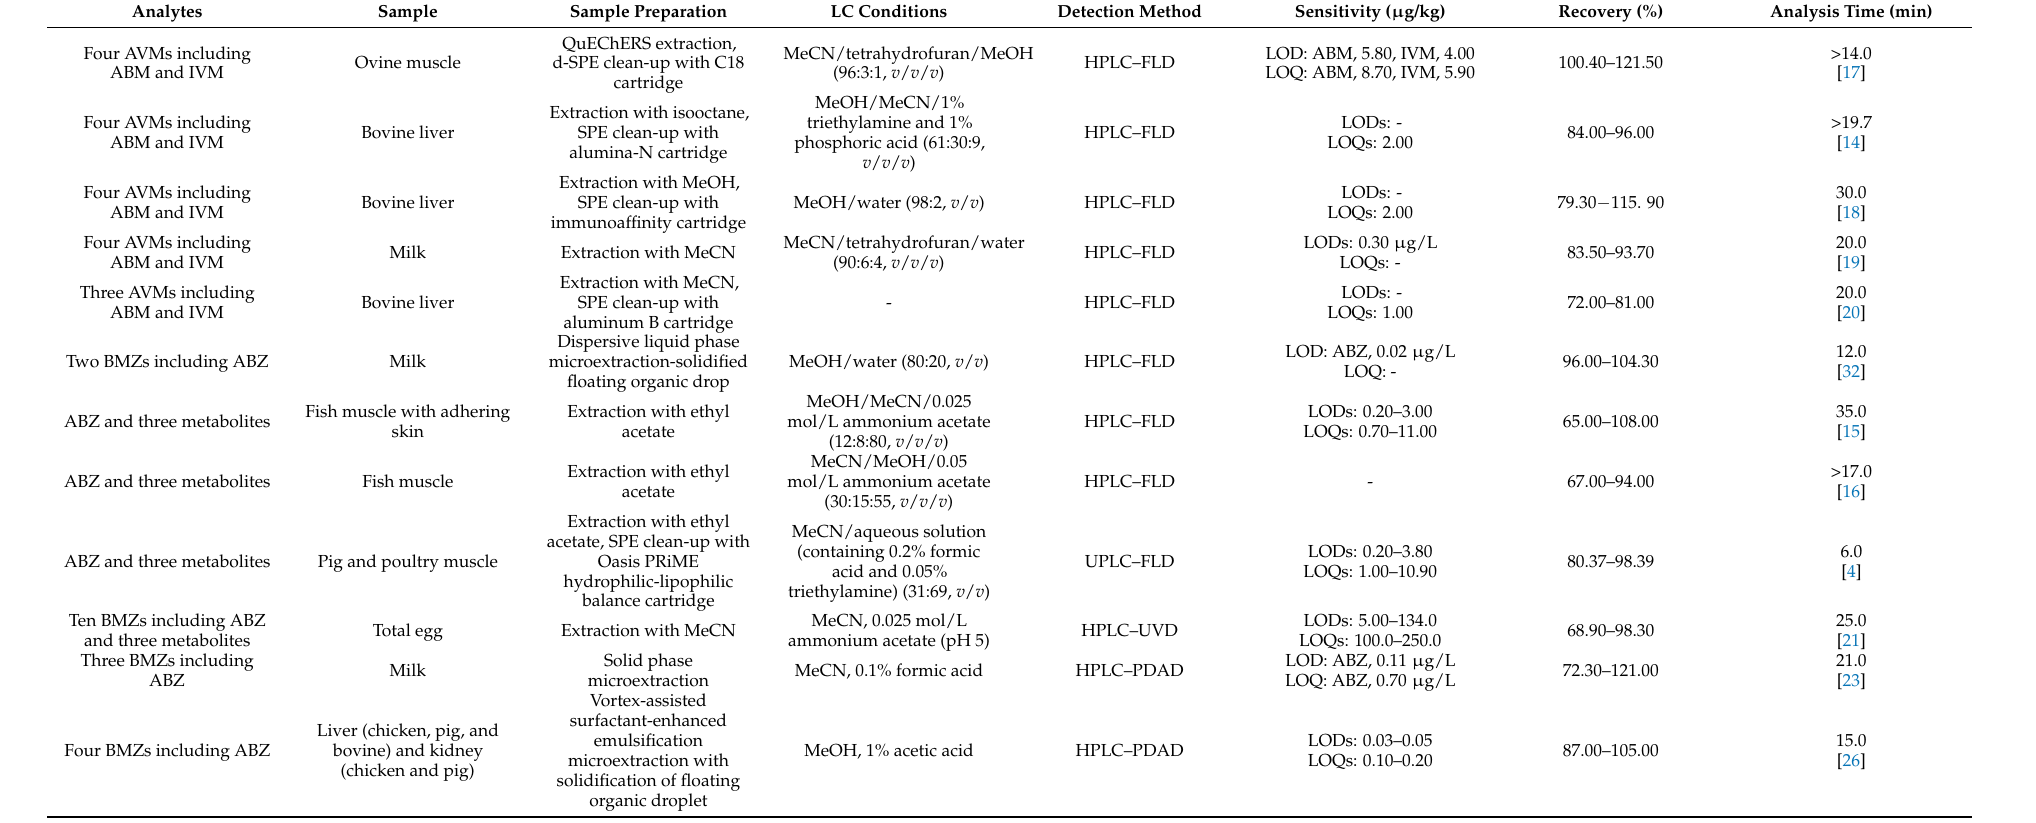
Table 5. Comparison with the reported LC methods for the detection of AVMs and BMZs in foods of animal